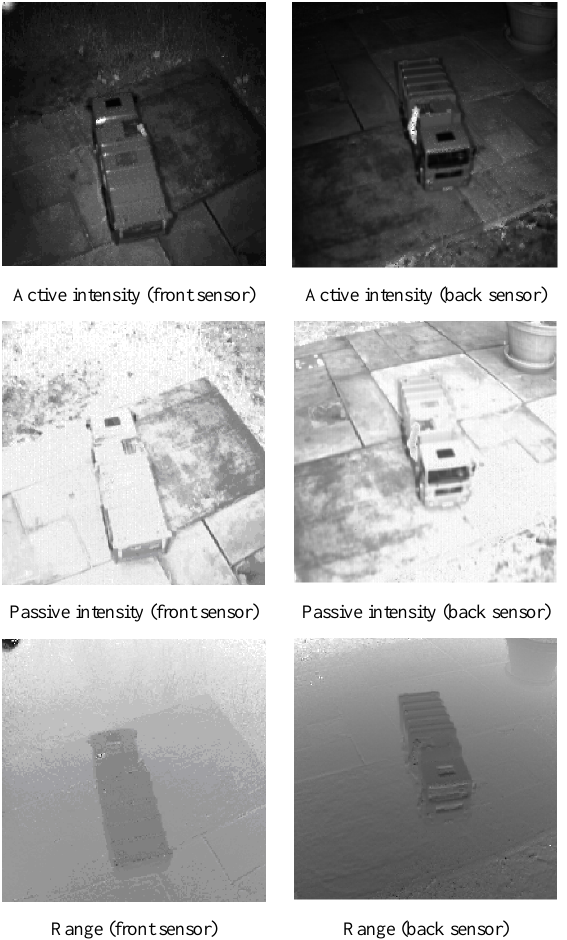
Figure 7. Image results of the convergent acquisition